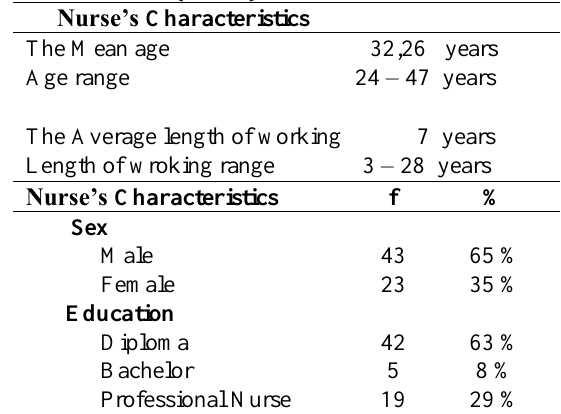
Table 1. Nurse Characteristics in Taking Care of Critical Patients (n = 66) Nurse’s Characteristics The Mean age 32,26 years Age range